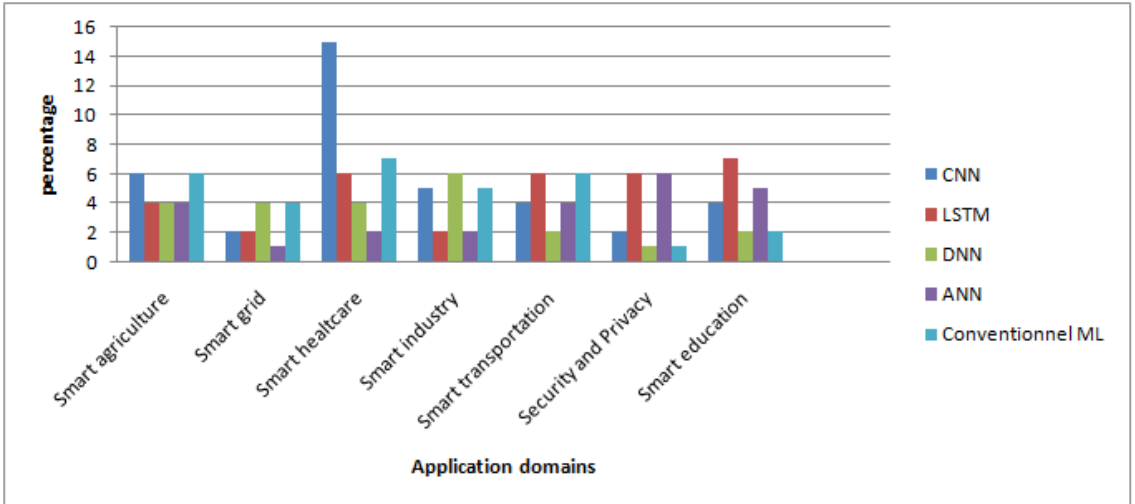
Figure 4. Percentage of the use of the convolutional ML and deep learning algorithms in the reviewed works.